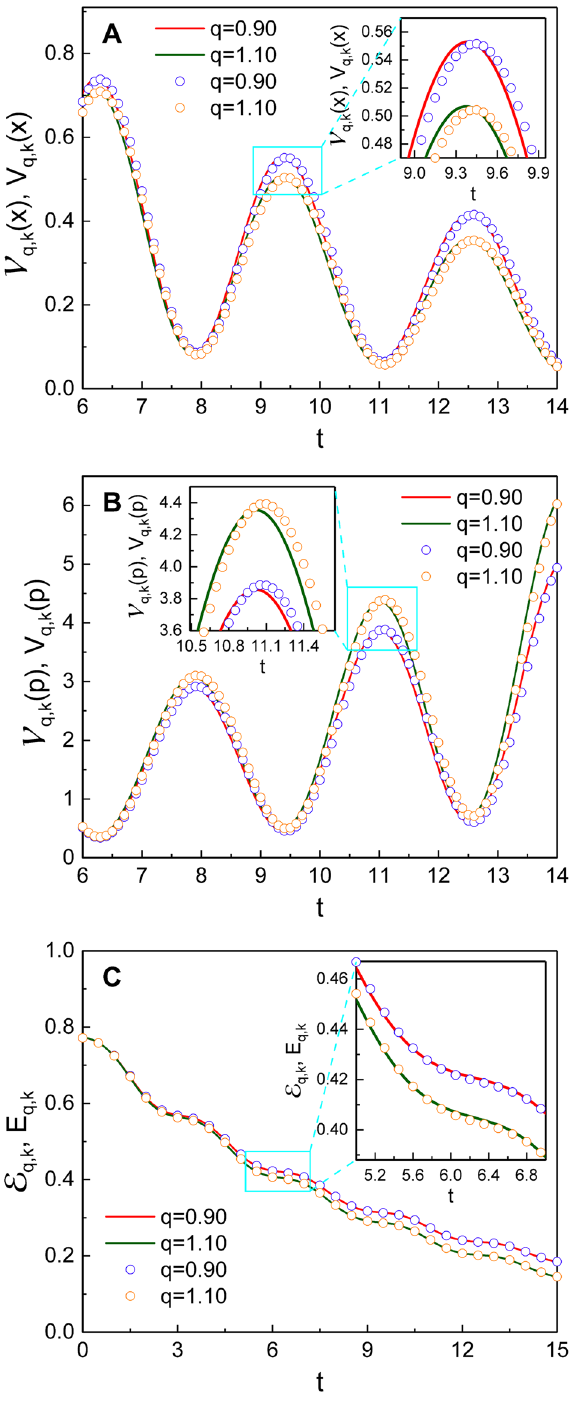
Figure 7. Comparison of the results of this research (solid curves) for V q , k ( x ) ( A ), V q , k ( p ) ( B ), and E q , k ( C ) with their counterpart results V q , k ( x ) , V q , k ( p ) , and E q , k in the previous research (circles) performed using DCOSHO. 0.1 . For the case based 1 , γ 1 , (cid:31) 1 , c 1 10 , k 0.1 , ϕ 0 0 , m 1 / 4 , and s 0,1 s 0,2 c 2 We used ω = = = = = = = = = = on DCOSHO, we used Eqs. (62)–(64), where ξ (actually, ξ 1 and ξ 2 ) were numerically evaluated from the real and imaginary parts of Eq. (61) with the initial value of ξ as the same value of ˜ ξ( 0 ) : ( ξ 1 ( 0 ) , ξ 2 ( 0 ) )=( ˜ ξ 1 ( 0 ) , ˜ ξ 2 ( 0 ) )= (0.462117, 0.0). Note that ˜ ξ 1 ( 0 ) is the same as ˜ ξ 0 in this case, which can be evaluated using Eq.